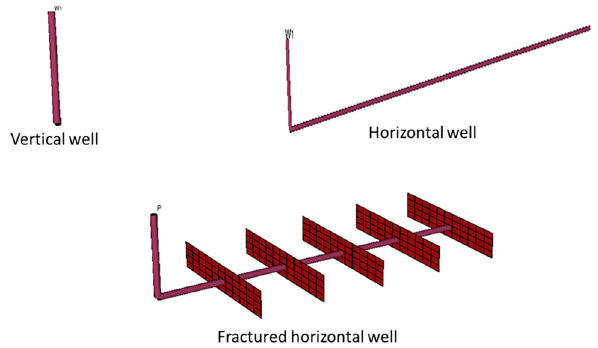
Fig. 9 Schematic map of vertical well, fractured vertical well, horizontal well, fractured horizontal well in shale gas reservoirs